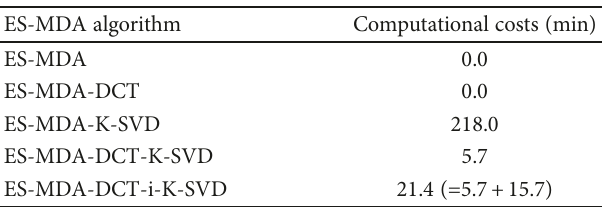
Figure 11: Permeability distribution of fi ve quali fi ed reservoir models obtained after history matching of Case 1. Table 6: Comparison of computational costs required for dictionary construction and